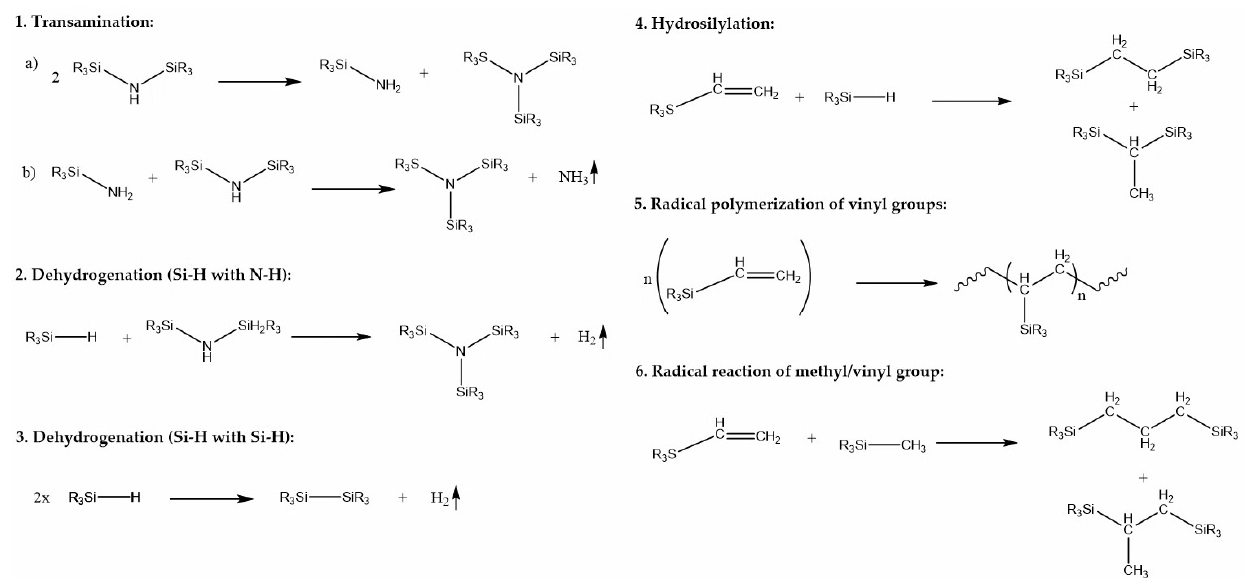
Figure 4. Several crosslinking reactions of Durazane 1800 involve ≡ Si-H, ≡ Si–NH–Si ≡ , and RCH=CH2 groups that can occur in inert atmosphere [9].